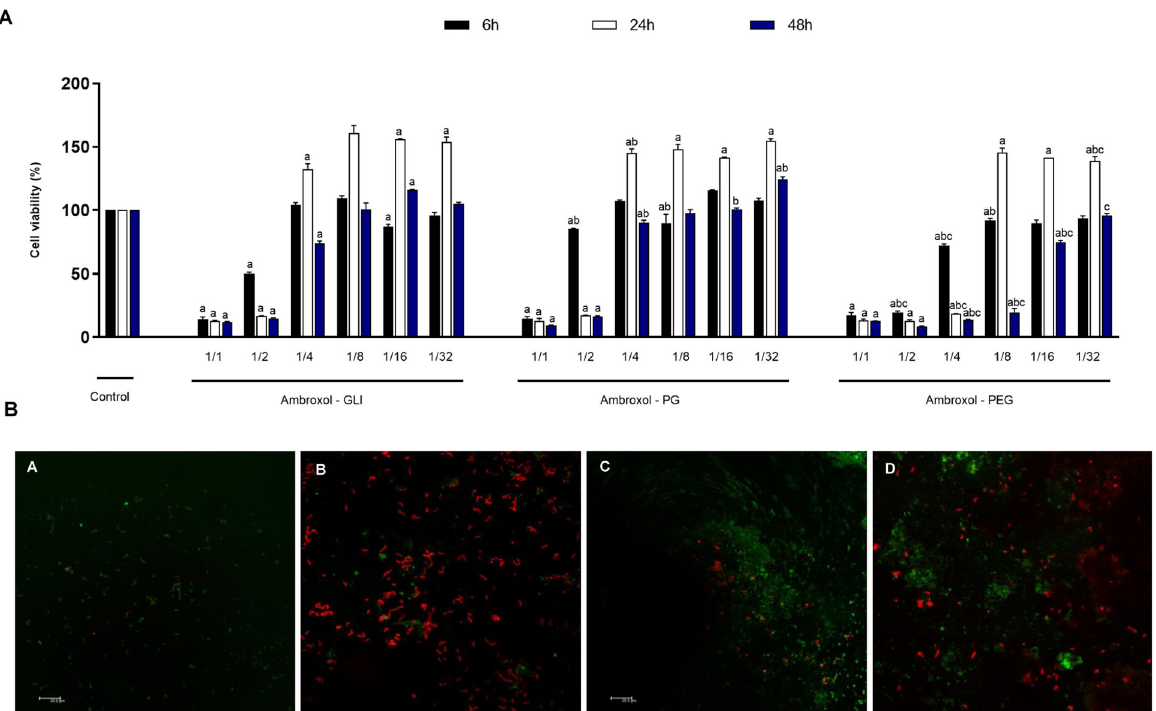
Fig. 1 A Cell viability observed after stimulation with diluted extracts of the Ambroxol associations at 6, 24 and 48 h. The letters indicate statistical difference when comparing different association at the same dilution. (a) p < 0.05 versus Control; (b): p < 0.05 versus Glycerin; (c): p < 0.05 versus Propylene Glycol. B Confocal laser scanning microscopy images of antimicrobial adhesion to sealer after setting after 2 h: (a) Control (coverslip); (b) Ambroxol-associated glycerin; (c) Ambroxol-associated Propylene Glycol; (d) Ambroxol-associated Polyethylene Glycol 400. Green and red fl uorescence represents live and death microorganisms, respectively. Scale bars: 20 µm Table 1 In fl ammatory scores specimens stained with hematoxylin-eosin, thickness of fi brous capsule and presence of mineralization in all